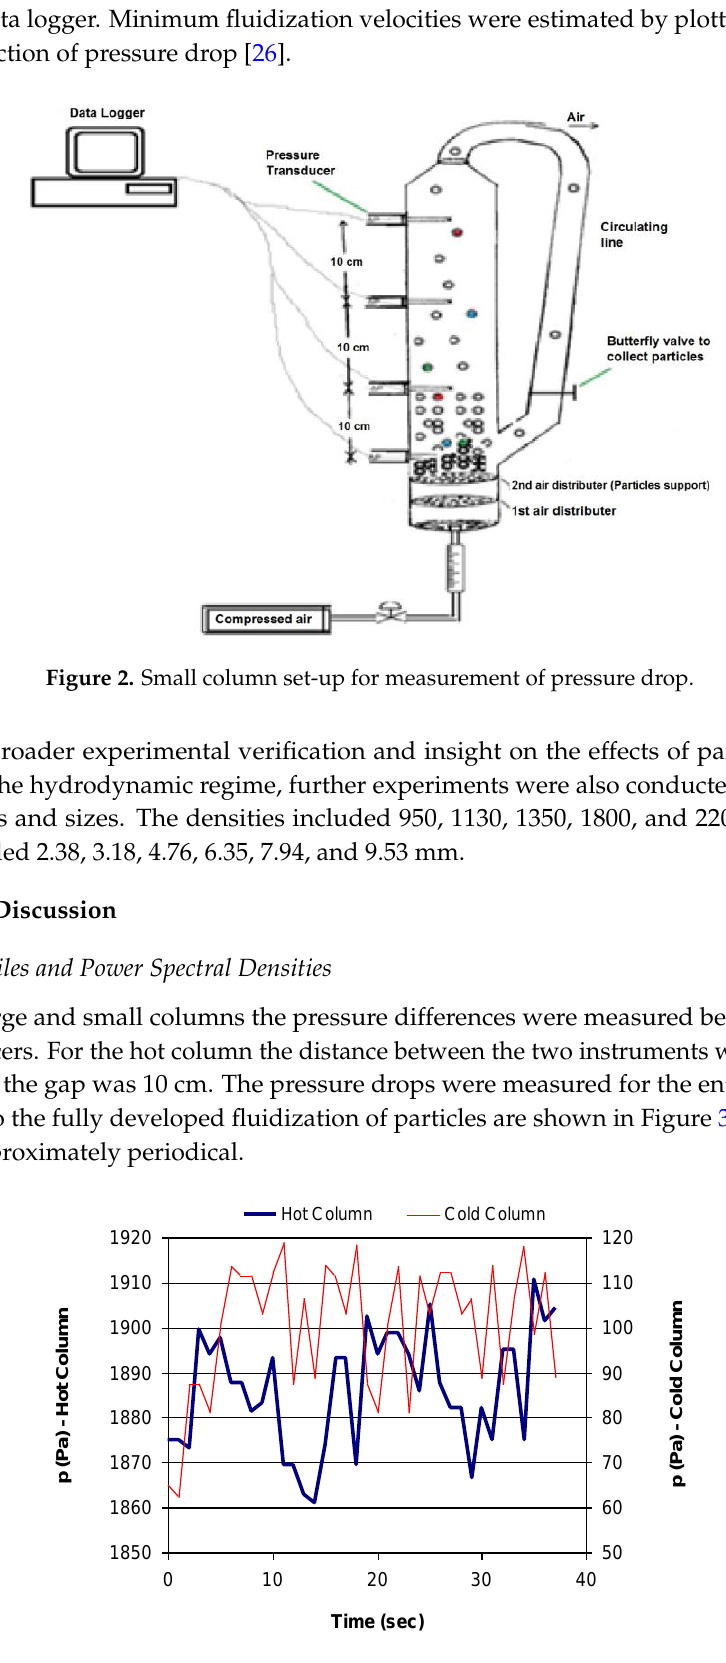
Figure 3. Comparison of pressure drops in the two columns during full fluidization.